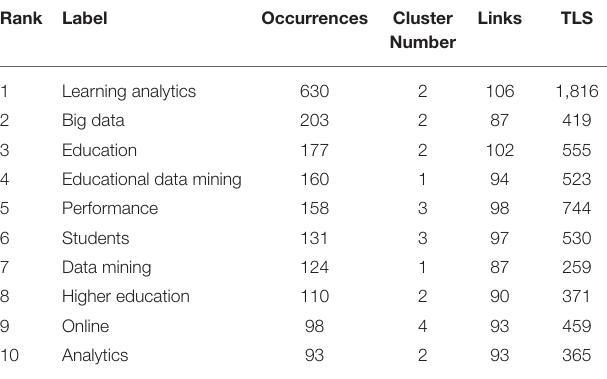
TABLE 3 | The details of top 10 occurrence